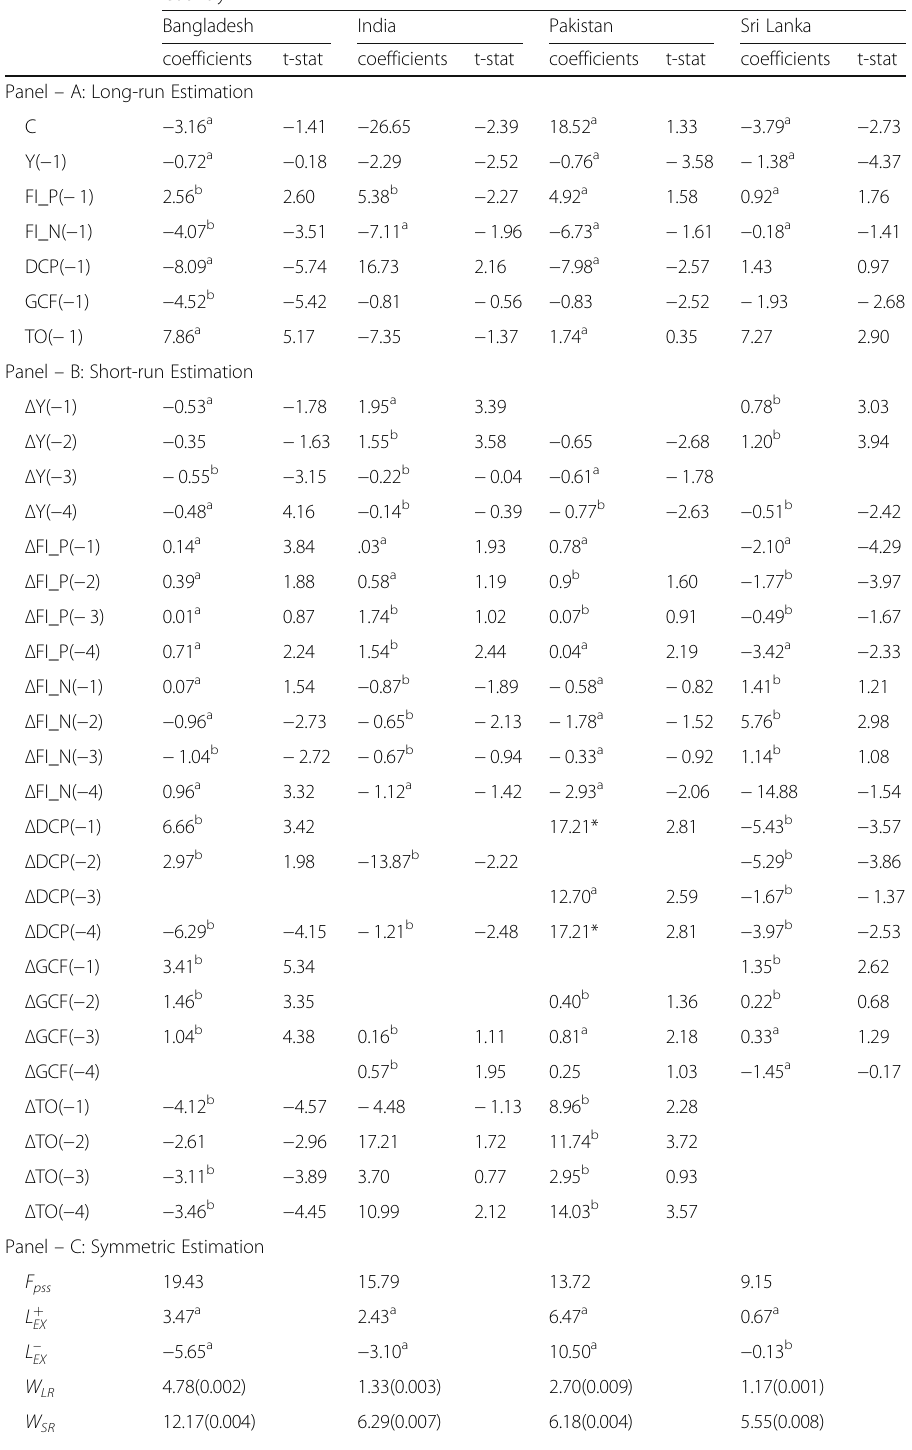
Table 5 Non-linear ARDL estimation